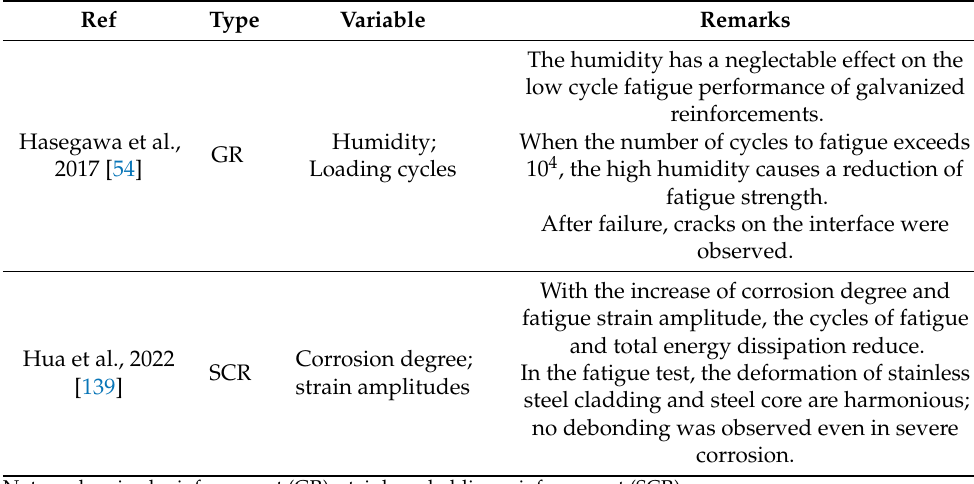
Table 6. Experiments on corroded fatigue properties of GR and